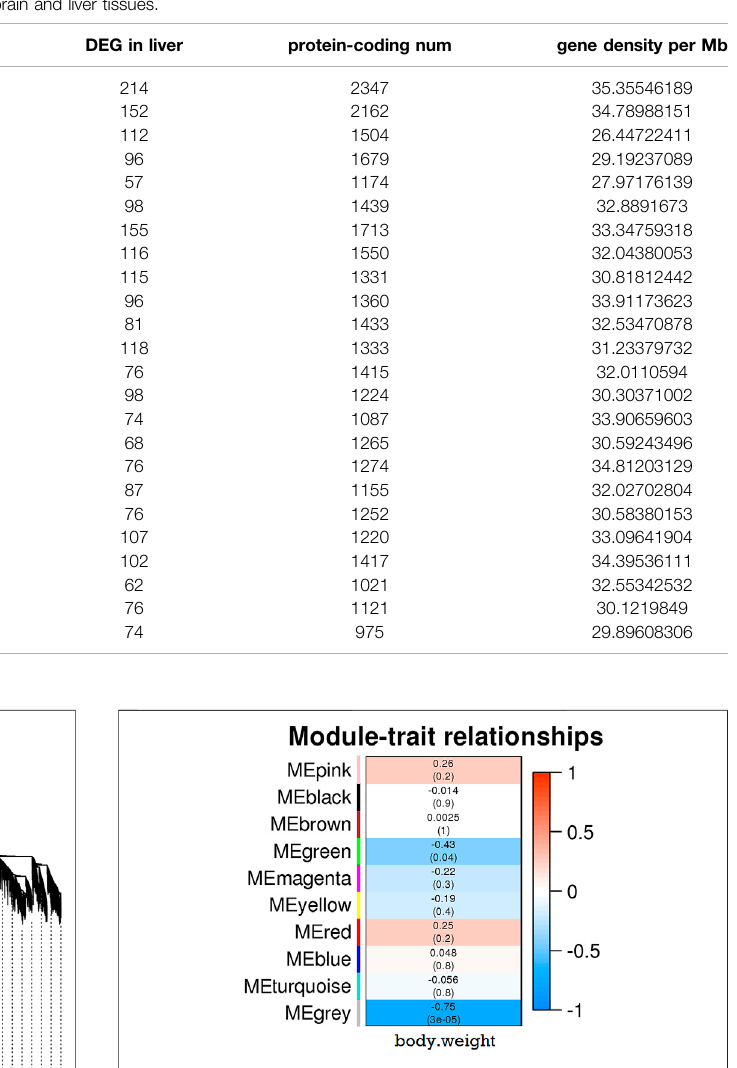
FIGURE 5 | The relationship between 10 modules and growth traits in samples. The eigengene in each module was calculated and shown in each row. The color bar indicates correlation value from low (blue) to high (red).